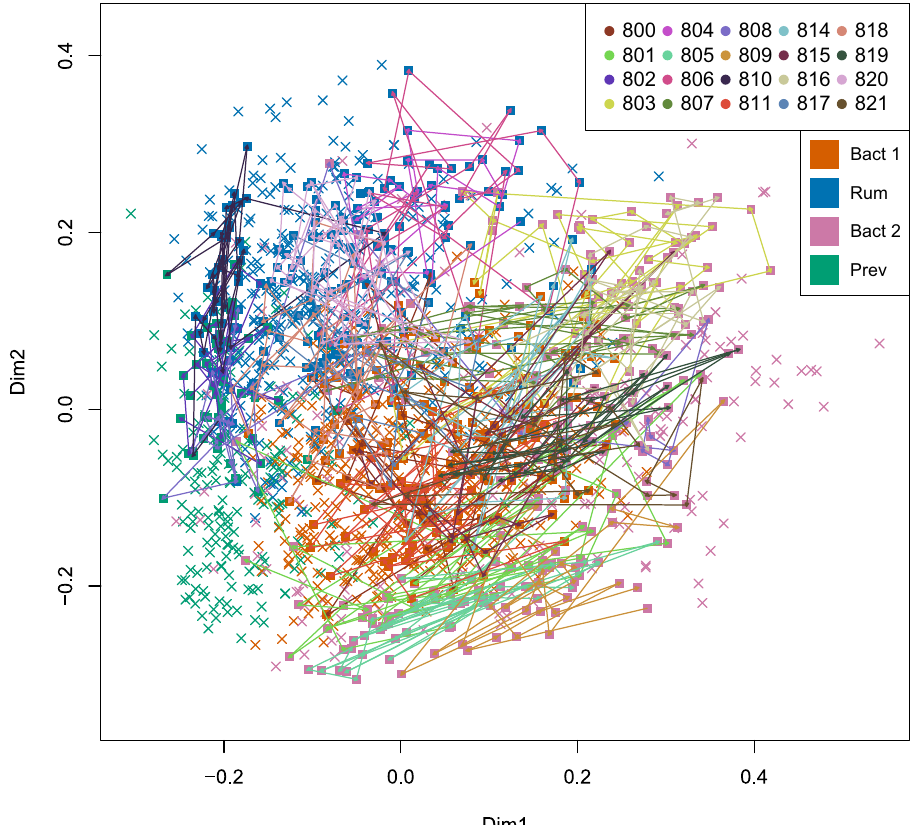
Fig. 4 Visualization of microbiome composition trajectories. Principal Coordinate Analyses of RMPs of the study cohort samples (squares) as well as 1104 FGFP participants (crosses), colored according to enterotype, namely Ruminoccocaceae (Rum, blue), Bacteroides 1 (Bact1, orange), Bacteroides 2 (Bact2, Pink), Prevotella (Prev, green). Arrows indicate the sampling sequence in time, color coded for respectively, P < 0.05, based on a multi-state Markov model. passage rates and vice versa: one-way Bact1-to-Rum shifts are 8% Similar results for BSS score). Interestingly, softer stools did not less likely with every percent increase in stool moisture, while one- associate with a movement towards a Prev constellation 8,43,46 . way Rum-to-Bact2 shifts are 74% more likely (relative risk with Consistent with the increased proteolytic/saccharolytic potential of each unit increase (risk ratio) for moisture content: 0.92 and 1.74,